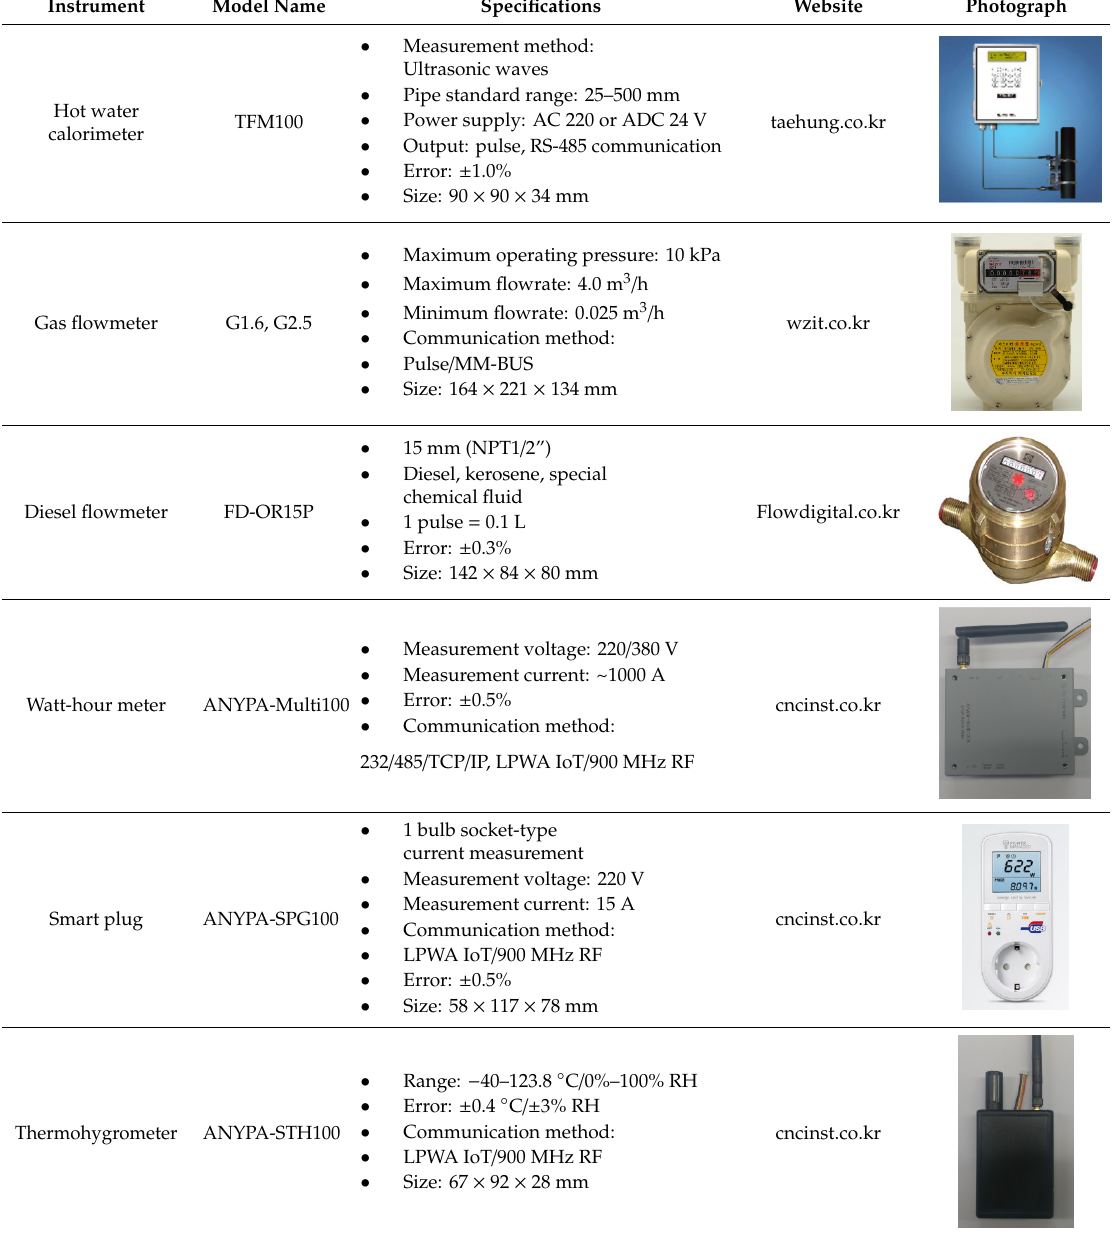
Table B1. Details of the measurement instruments.